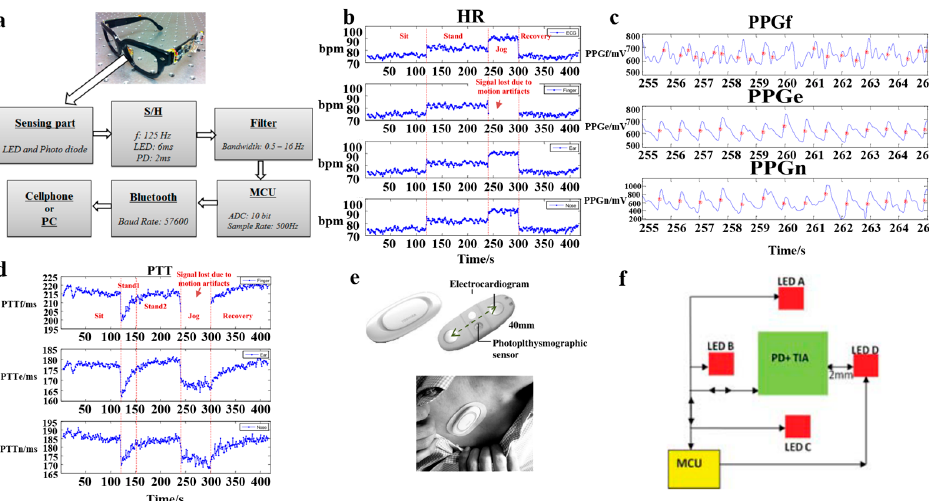
Figure 4. ( a ) The eyeglasses-based PPG measurement device; ( b ) The averaged HR; ( c ) PPGf, PPGe, and PPGnrch are PPG measured from the finger, ear, and nose, respectively; ( d ) The averaged PTT; Reproduced with the permission of [56]. Copyright 2012, IEEE. ( e ) Prototype of a wearable sensing device; Reproduced with the permission of [57]. Copyright 2013, IEEE. ( f ) Block diagram for the proposed 4-LED/one-photodiode PPG sensor. Reproduced with the permission of [44]. Copyright 2016, IEEE.